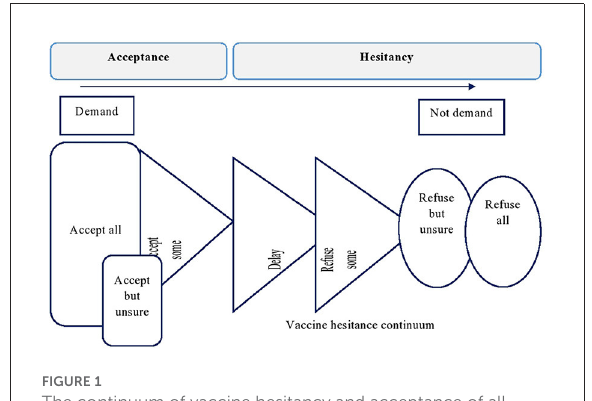
FIGURE1 The continuum of vaccine hesitancy and acceptance of all vaccines. [Source